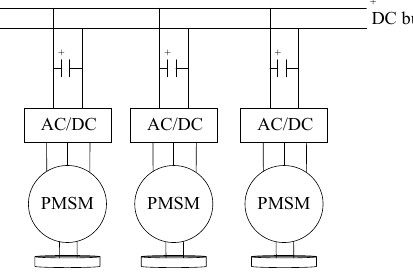
Fig. 13. Energy harvesting block diagram based on